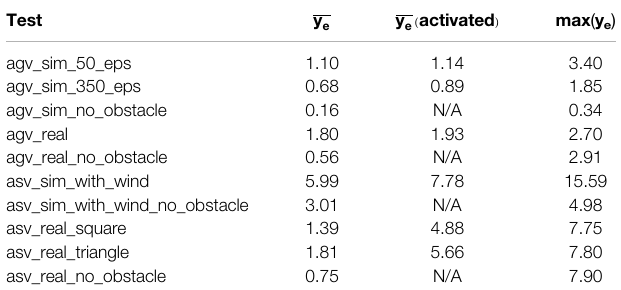
TABLE 2 | Cross-track error of different tests. y e column lists the average cross- track errors across the entire mission, y e ( activated ) column lists the average cross-track errors when the DRL agent is activated, and max(y e ) column lists the max cross-track error observed during the entire test. Tests with no obstacles are not shown within this work.